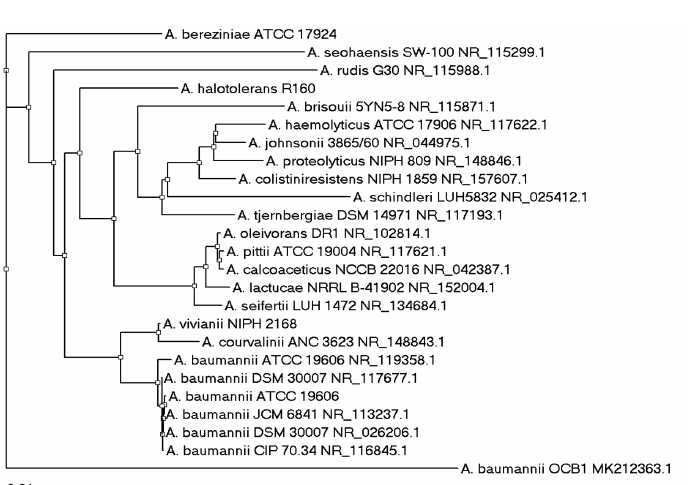
Fig. 4c. Phylogenetic tree showing the relationship of isolated OCB1 with isolates showing homology as obtained from BLASTn